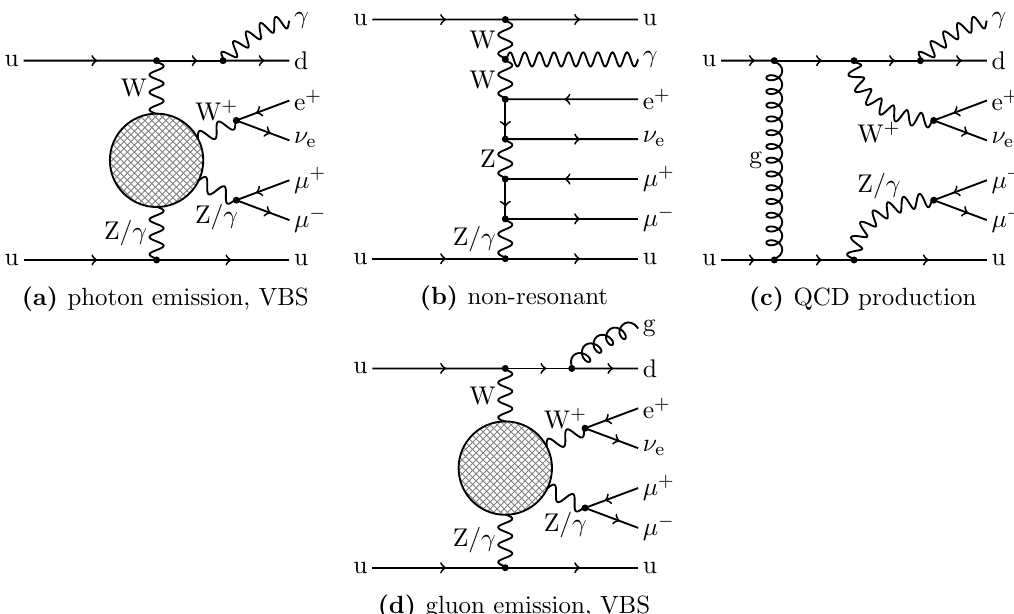
Figure 3. Sample diagrams for real